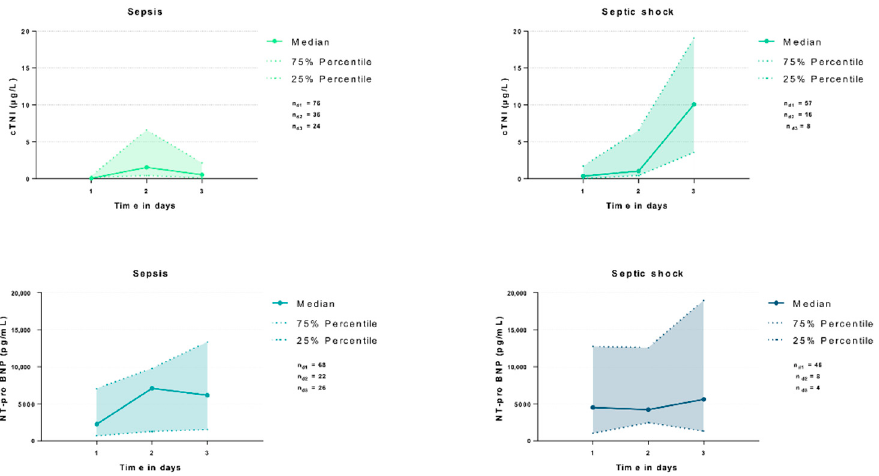
Figure 2. Distribution of cTNI and NT-pro BNP among patients with sepsis and septic shock during the first 3 days of sepsis.